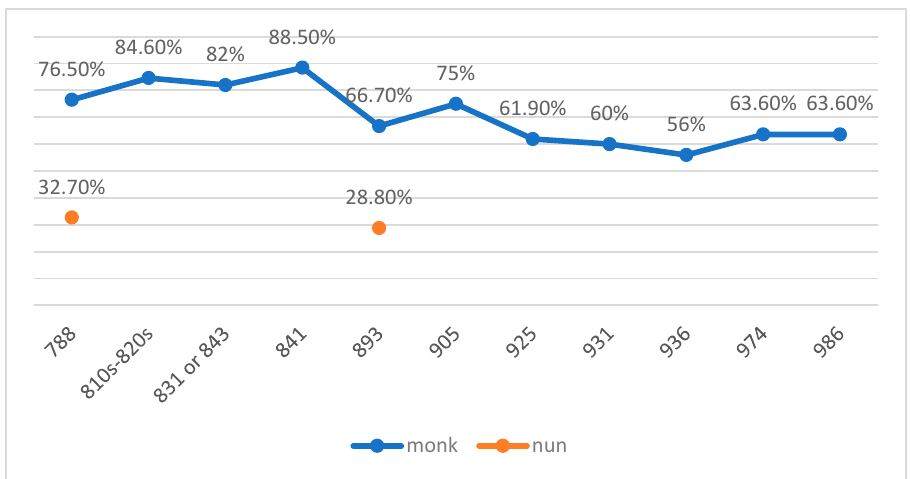
Chart 1. The literacy rate of Buddhist monks and nuns in Dunhuang during the late Tang, Five Dynasties, and early Song Period. Dynasties, and early Song